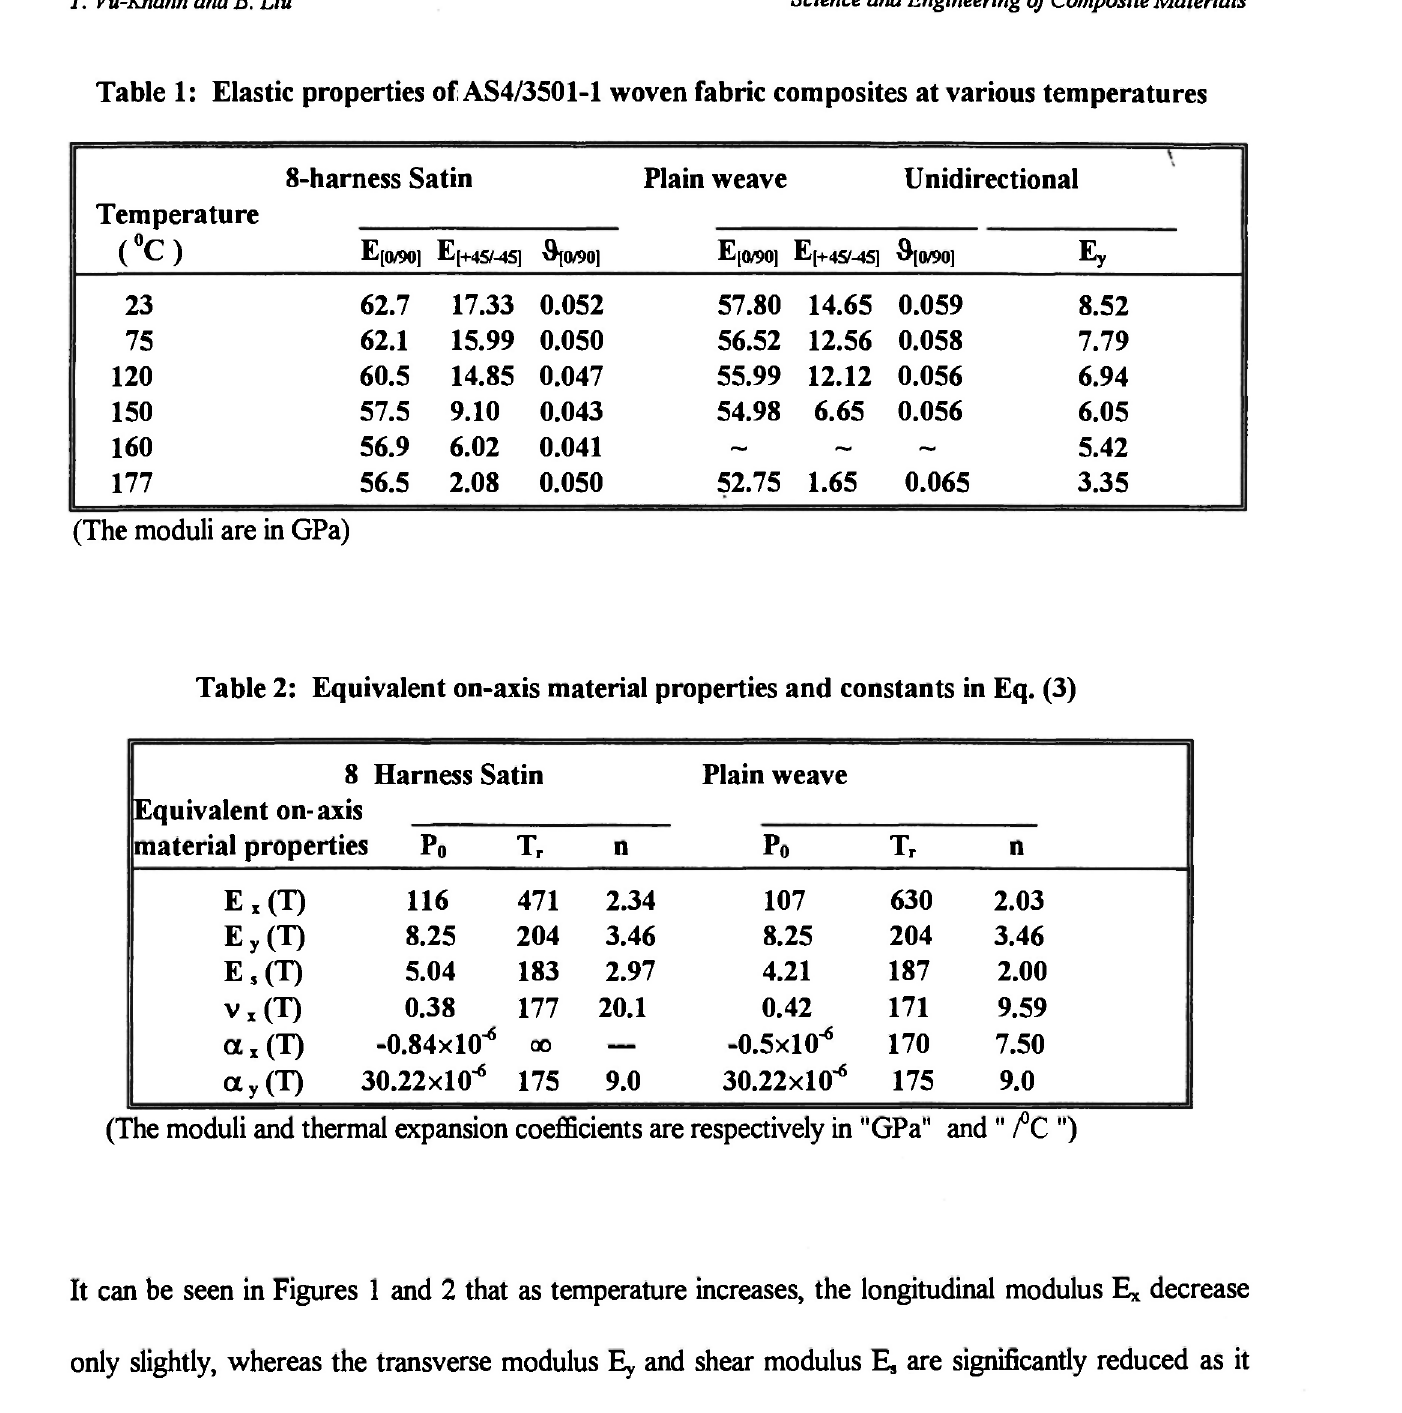
Table 1: Elastic properties of AS4/3501-1 woven fabric composites at various temperatures